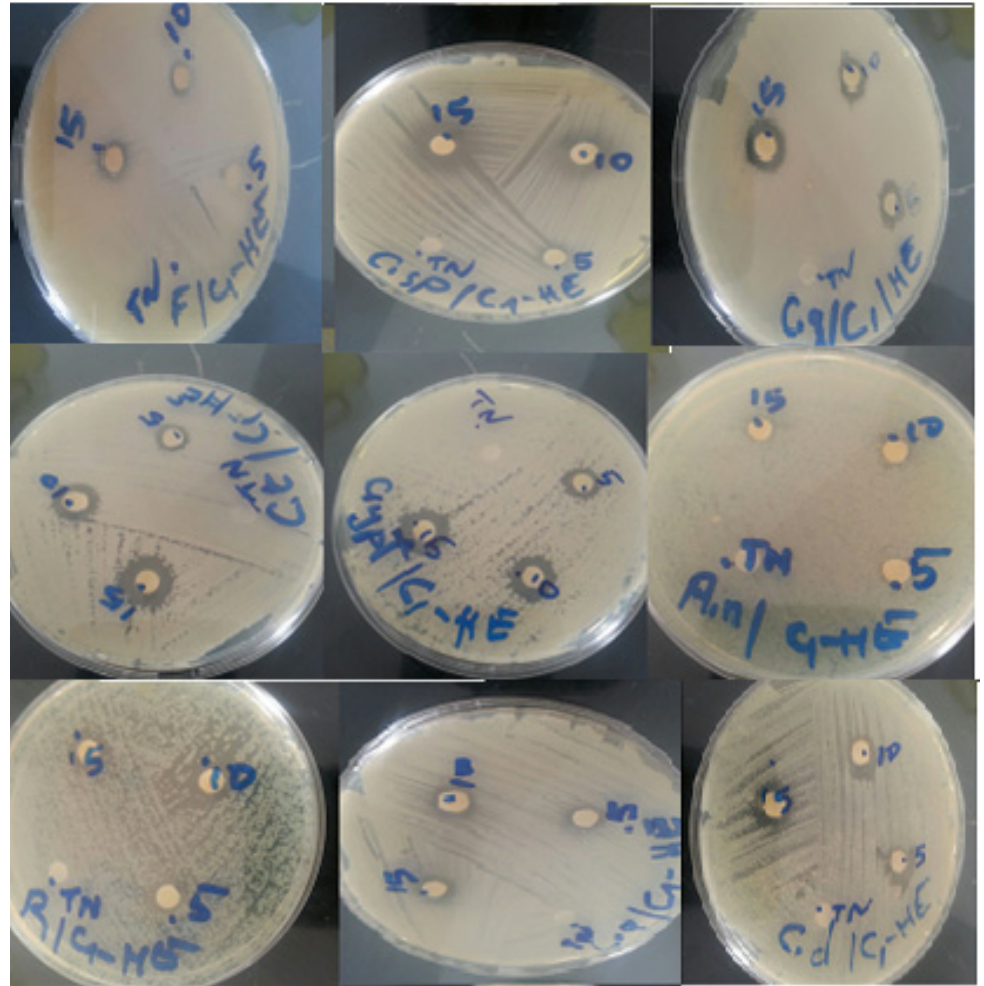
Figure 3. Fungal strains zone of inhibition diameters of essential oil of C. ladanifer . Minimum Inhibitory Concentrations (MIC) and Minimum Fungicide Concentrations Table 6. Values of the inhibition diameters zone of the essential oil of C. ladanifer . (MFC) Growth Inhibition Diameter (GID) (mm) Fluconazole GID Fungal Strains